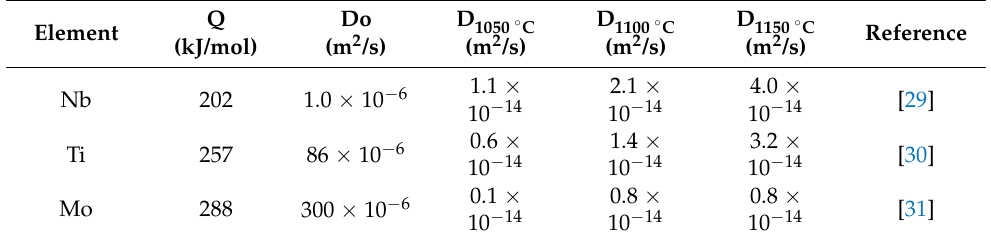
Table 9. Parameters for diffusivity calculation of Nb, Ti, and Mo in Ni and calculated diffusivities. Q Do Element (kJ/mol) (m 2